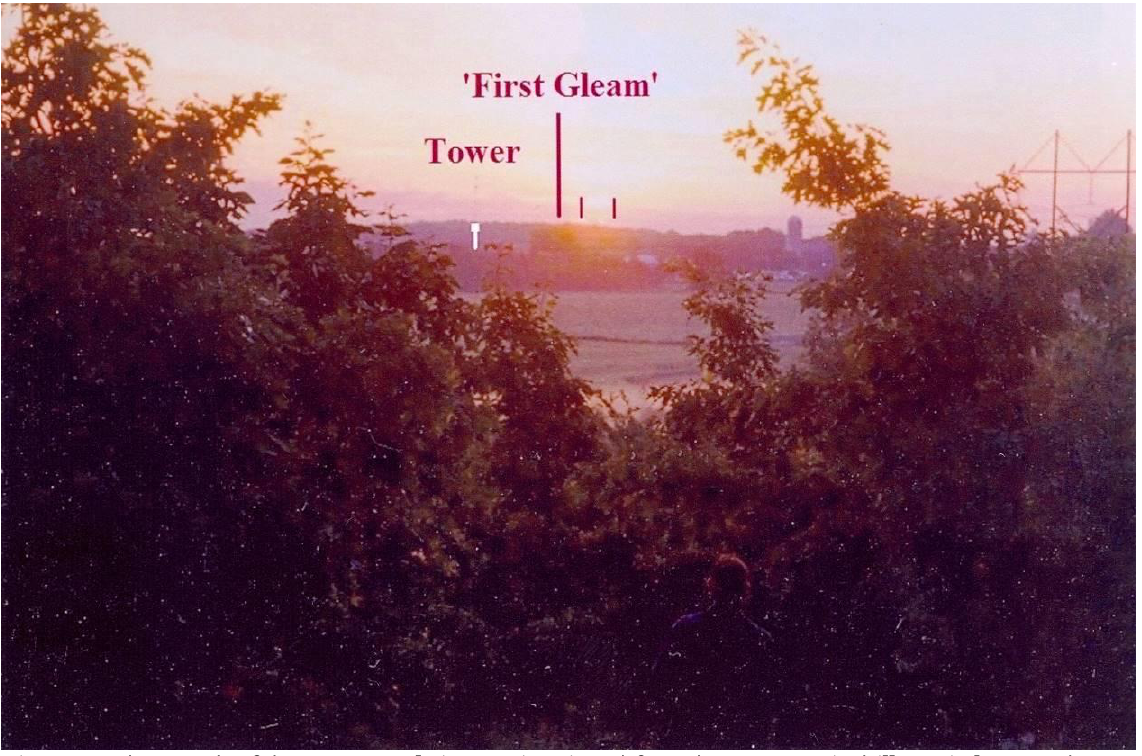
Figure 16. Photograph of the summer solstice sunrise viewed from the Starman site hilltop circle. Note the sun (between the two parallel vertical lines) and its extreme shift south (right) of the centre of the hill marked by a tower and white line. Three parallel summer solstice alignments at the Starman site point at the direct centre of the hill which is approximately 3 km distant across the marsh (Figures 2 and 7). Table 1: Stellar rise azimuths about 1500 BCE at 43.75° N. latitude. (Rise azimuths calculated at approximately 1.5 - 2.5° elevation unless noted). Current and precession stellar rise values calculated from SkyMap Pro Version 8 (Marriott